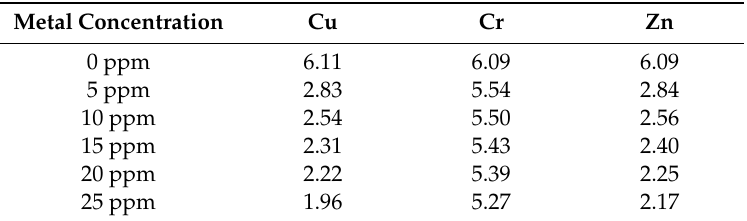
Table 9. pH of single metal solutions used in the